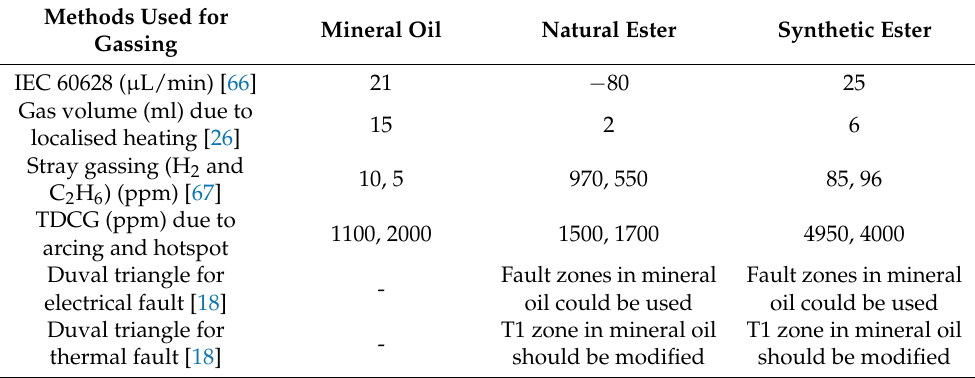
Table 1. Characterization on the gassing of different insulating